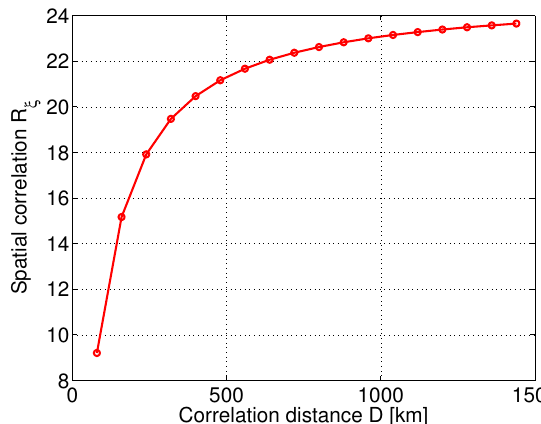
Figure 4. Spatial correlation as a function of correlation distance with a fixed distance